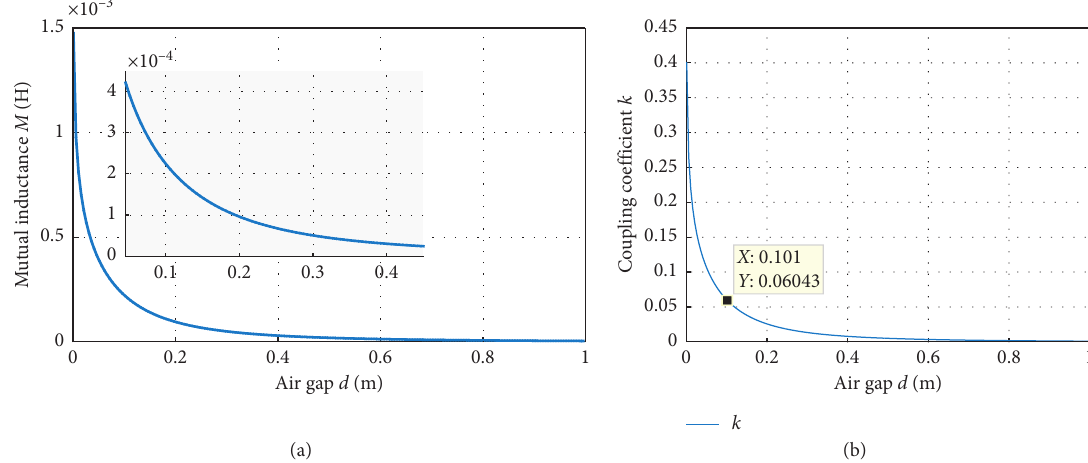
Figure 3: Effect of air gap distance on the (a) mutual inductance and (b) coupling coefficient.